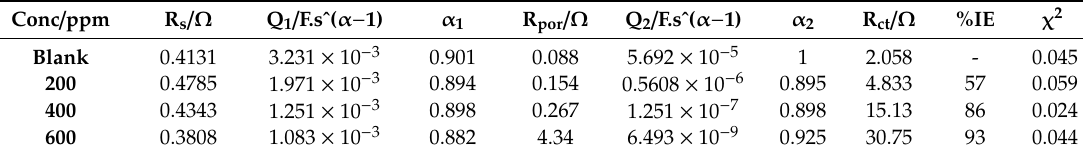
Table 2. The EIS parameters of mild steel in 1 M HCl in the absence and presence of PBSLP. Conc / ppm R s / Ω Q 1 / F.sˆ( α −